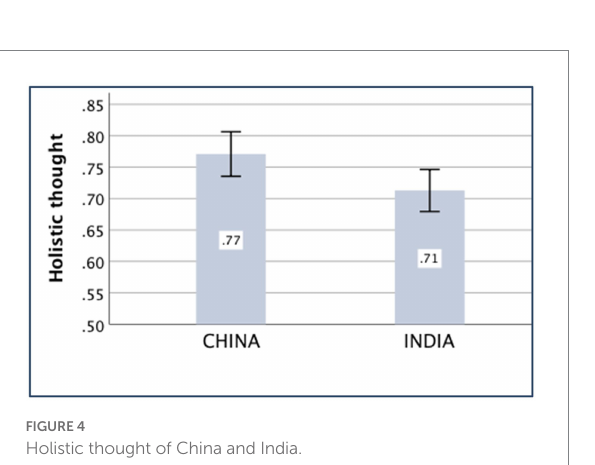
FIGURE 4 Holistic thought of China and India.